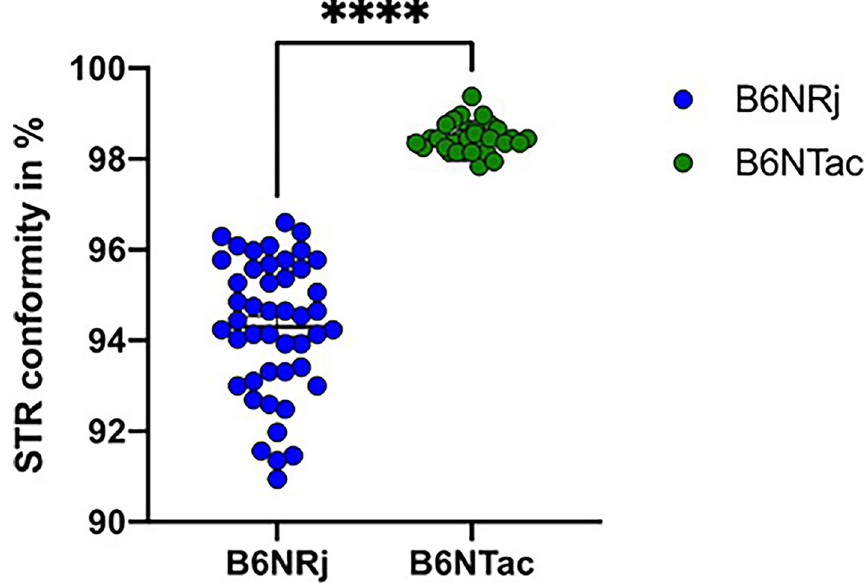
Figure 2. STR conformity in % in C57BL/6NTac and C57BL/6NRj mice. The degree of conformity of the genotype of an individual with the consensus STR-genotype of its strain is calculated by comparing STR alleles for all STR markers. The value of 1 is allocated if both alleles are identical with the consensus allele, a value of 0 if both allels differ and a value of 0.75 if there is a heterozygous match. The resulting sum of all values is then divided by the number of markers and a percentage figure describing the match between the individual and the consensus STR-genotype is obtained. All data are shown as mean ± SEM. **** p<0.0001 ( unpaired t-test with Welch´s correction).